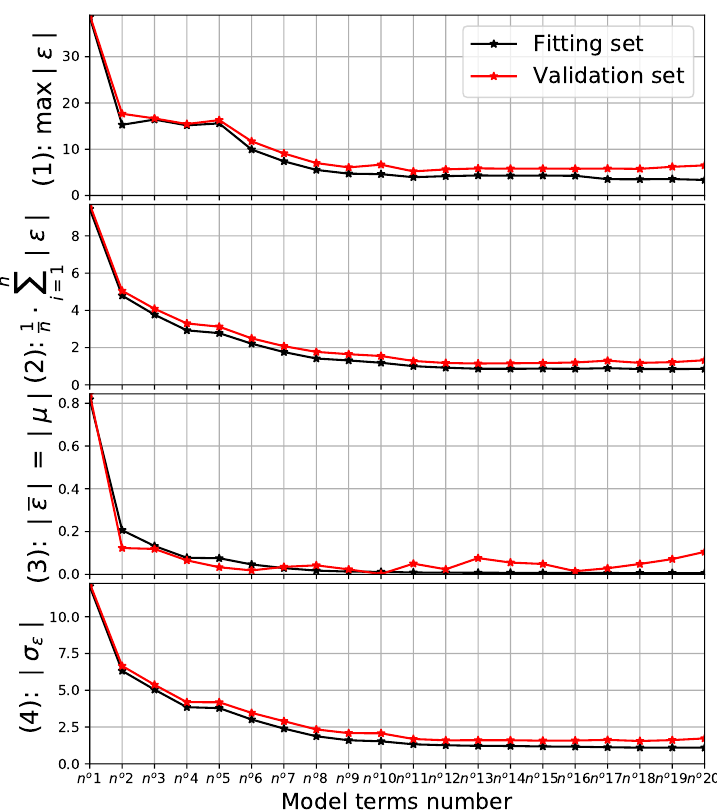
Figure 9. Output of regression model performed on π 1 —errors and standard